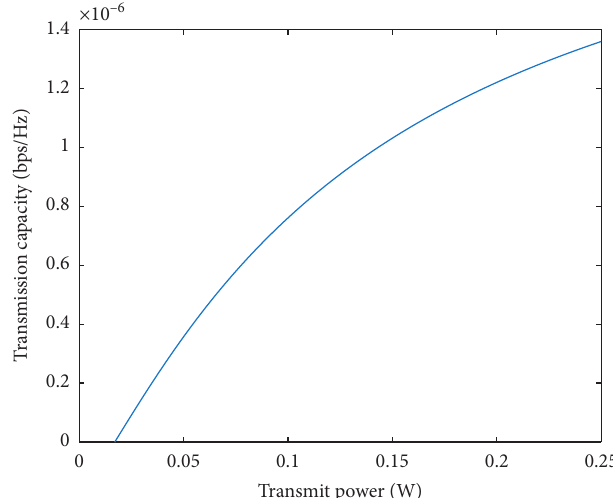
Figure 3: Relationship between transmission capacity and transmit